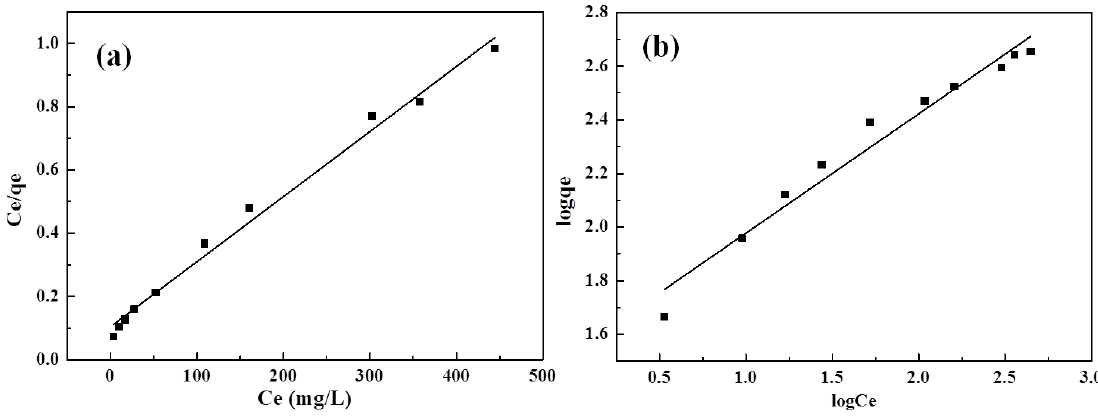
Figure 10. Langmuir ( a ) and Freundlich ( b ) adsorption isotherm models of MB.